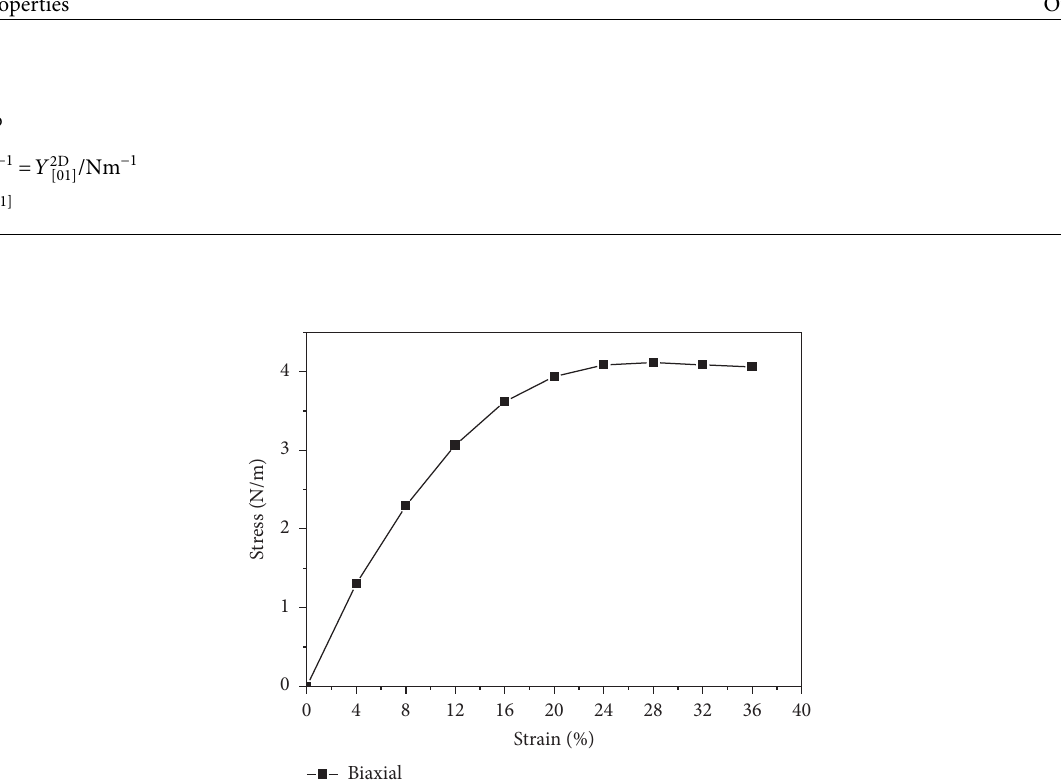
( Nm − 1 ) and shear modulus G 2D , layer modulus c ij / G ) for the monolayer CaHBr. 0 2D